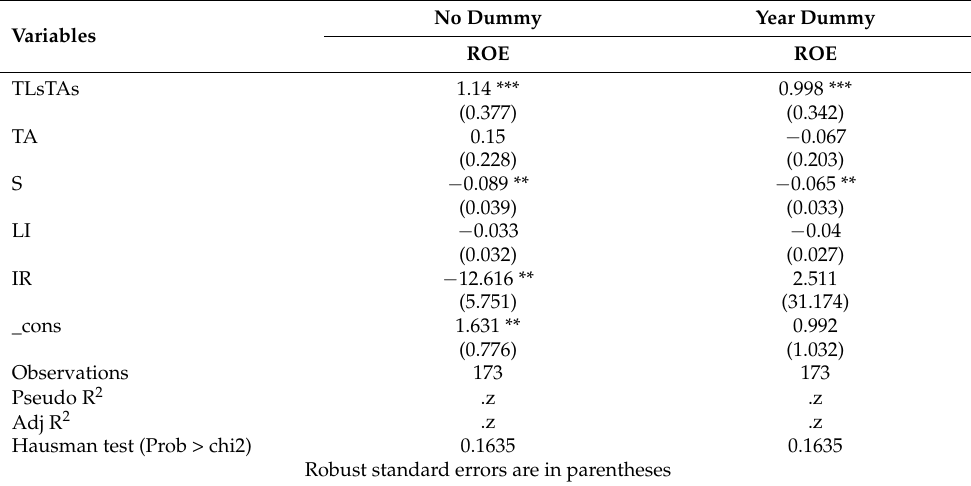
Table 19. Results of the Random Effects of TLsTAs on ROE, as per Panel Data Regression (Profit- Making Subsample).